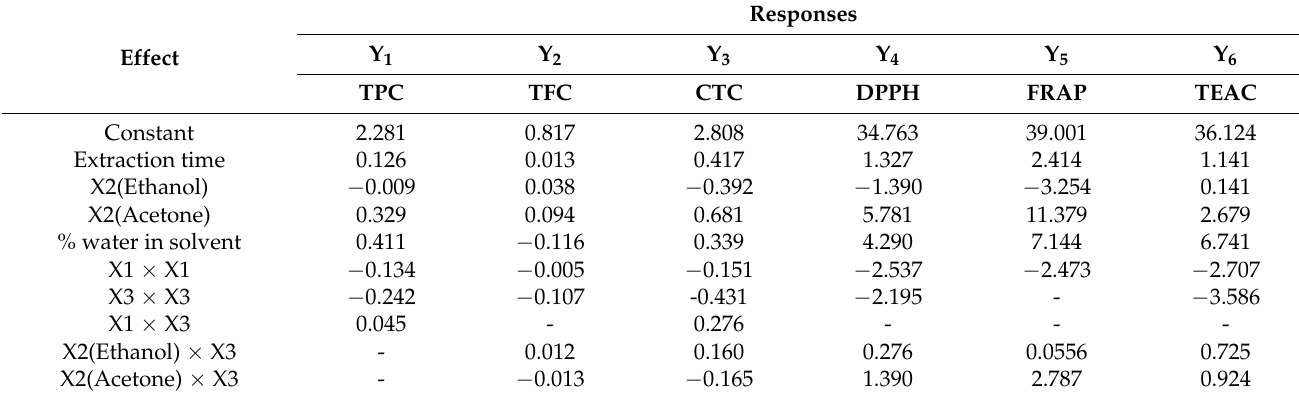
Table 4. Regression equation coefficients for total bioactive compounds and antioxidant activity in walnut flower extracts.